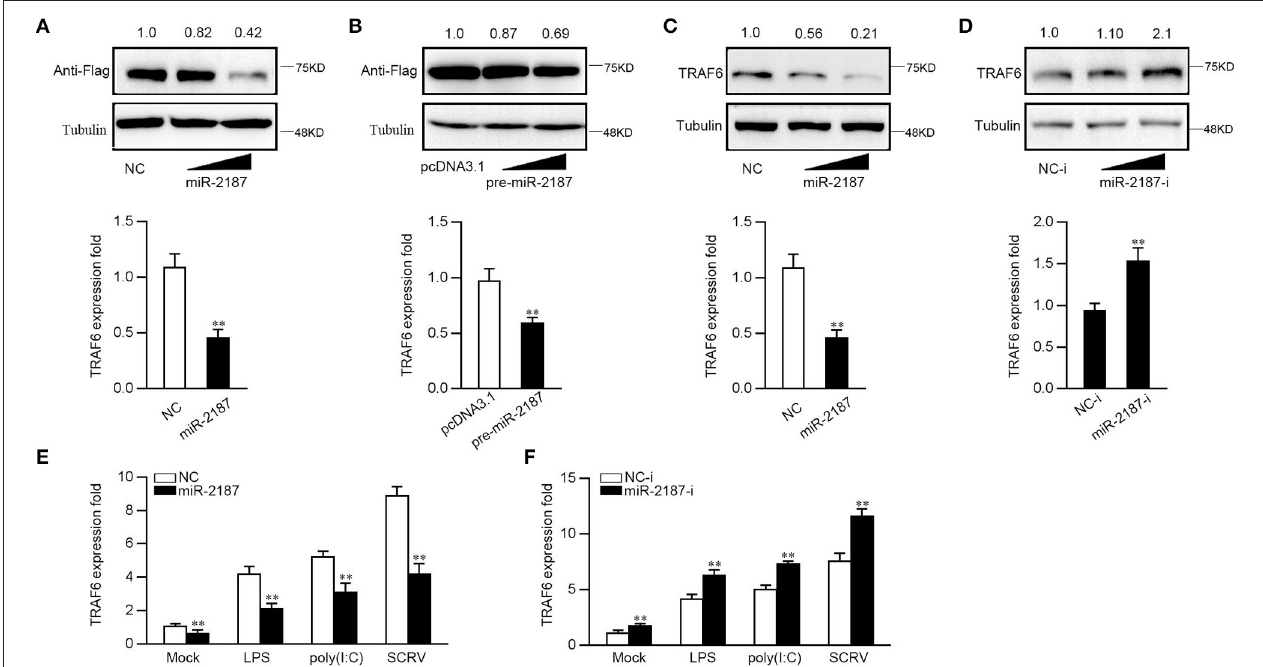
FIGURE 4 | miR-2187 inhibits the expression of TRAF6. (A,B) EPC cells were co-transfected with TRAF6 expression plasmid, pcDNA3.1 or pre-miR-2187 along with NC or miR-2187 (A) and pcDNA3.1 or pre-miR-2187 (B) . After 48h, western blotting (upper panel) or qRT-PCR (lower panel) was used to determine the expression of TRAF6, respectively. (C,D) MKC cells were transfected with NC or miR-2187 (C) and NC-i or miR-2187-i (D) . After 48h post-transfection, the protein and mRNA expression of TRAF6 were detected by western blotting (upper panel) or qRT-PCR (lower panel), respectively. (E,F) After transfection of NC or miR-2187 (E) and NC-i or miR-2187-i (F) for 48h, MKC cells were treated with LPS, poly(I:C) or SCRV, respectively. The mRNA expression of TRAF6 was analyzed by qRT-PCR and normalized to β -actin. All data are presented as the means ± SE from three independent triplicated experiments. ** p < 0.01 vs. the